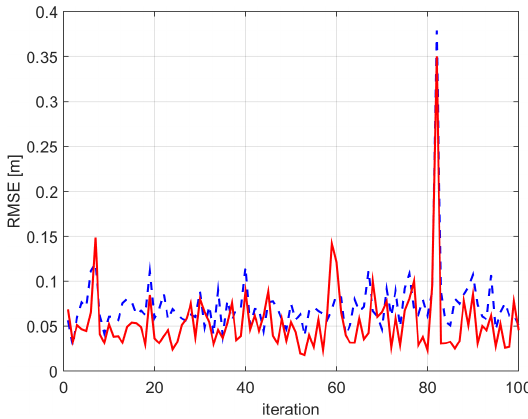
section 5. (red solid line) in the 100 independent simulations. The proposed method allow to ensure an average 38% reduction of the RMSE in the 100 simulations.